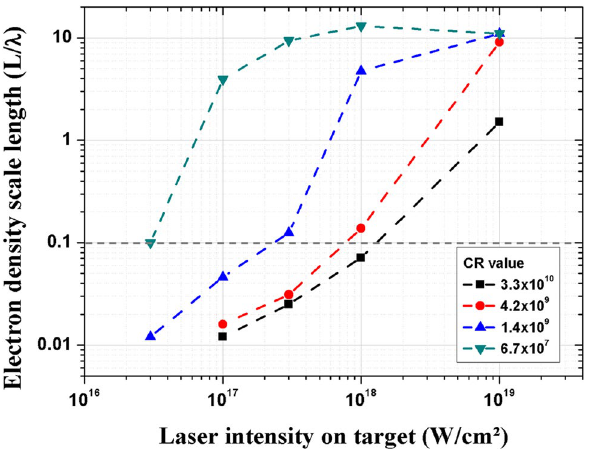
Figure 2. Simulated pre-plasma density scale length L normalized by λ for the four experimental CR studied and from I = 3.0 × 10 16 W/cm 2 to 1.0 × 10 19 W/cm 2 . At relativistic laser intensity regime (I > 2.2 × 10 18 W/ cm 2 ), the Lorentz factor γ must be considered in the calculation of the critical density n c , giving a measured L at I = 10 19 W/cm 2 lower than the one at I = 10 18 W/cm 2 for CR = 6.7 × 10 7 . The grey horizontal dashed line represents L/λ =